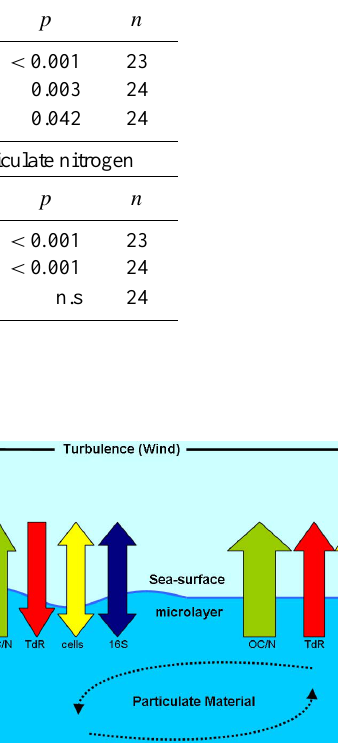
Fig. 5. Model of the effect of decreasing wind speed on organic mat- ter enrichment and bacterioneuston parameters in the sea-surface microlayer compared to the underlying water. The present study indicates that slick formation and an artificial calming of the sea surface result in an increasing importance of the particulate fraction in the SML under lower wind conditions. (OC/N=organic carbon and nitrogen, TdR= 3 H-thymidine incorporation, cells=bacterial abundance, 16S=differences in community composition based on 16S rRNA